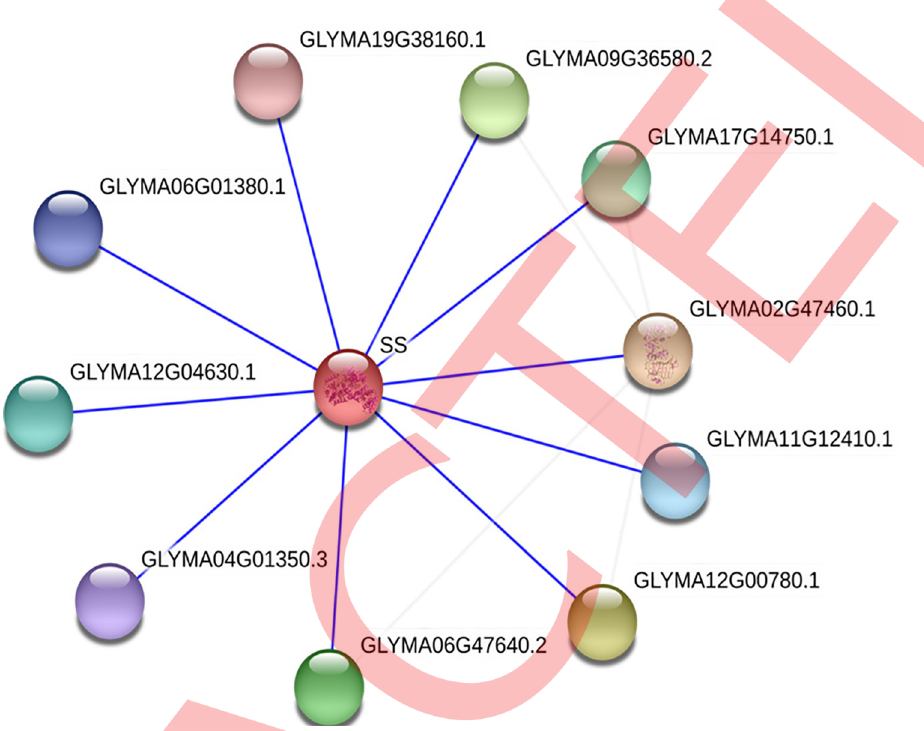
Fig 4. The protein–protein interaction (PPI) network built by STRING database for GmSS5 gene. Line thickness indicates the strength of the interaction. Network nodes denote proteins’ post-transcriptional modifications or splice isoforms, and each node represents all the proteins produced by a single, protein-coding gene